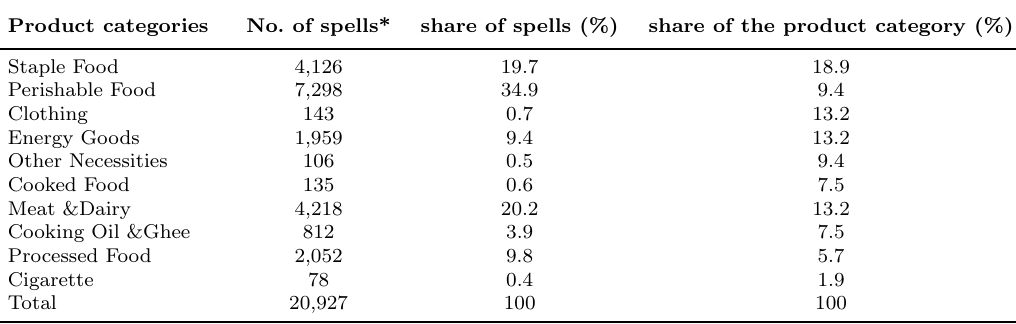
Table 3: Description of Product Categories